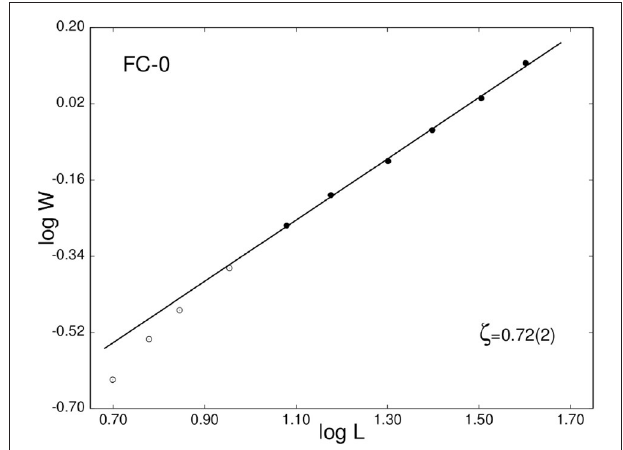
FIGURE 7 | Comparison of fracture surfaces obtained with different fracture criteria. Three different samples are shown, S-134, S-135, and S-136. FC-0 denotes the “original” criterion, Equation (22), and FC-2 denotes the “maximum shear stress” criterion, Equation (77). Fracture interfaces are red on the underside and blue on top.